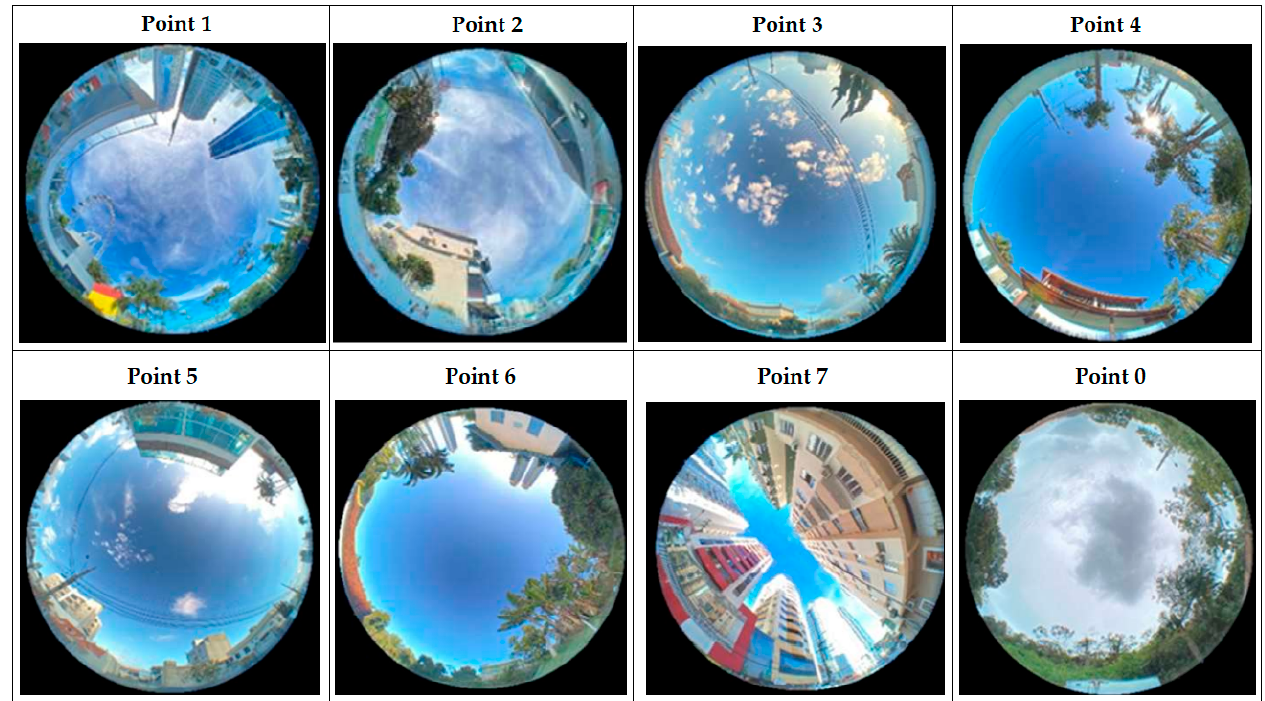
Figure 6. SVF of the urban climate data collection points in Balneário Camboriú. Source: The authors (2022).